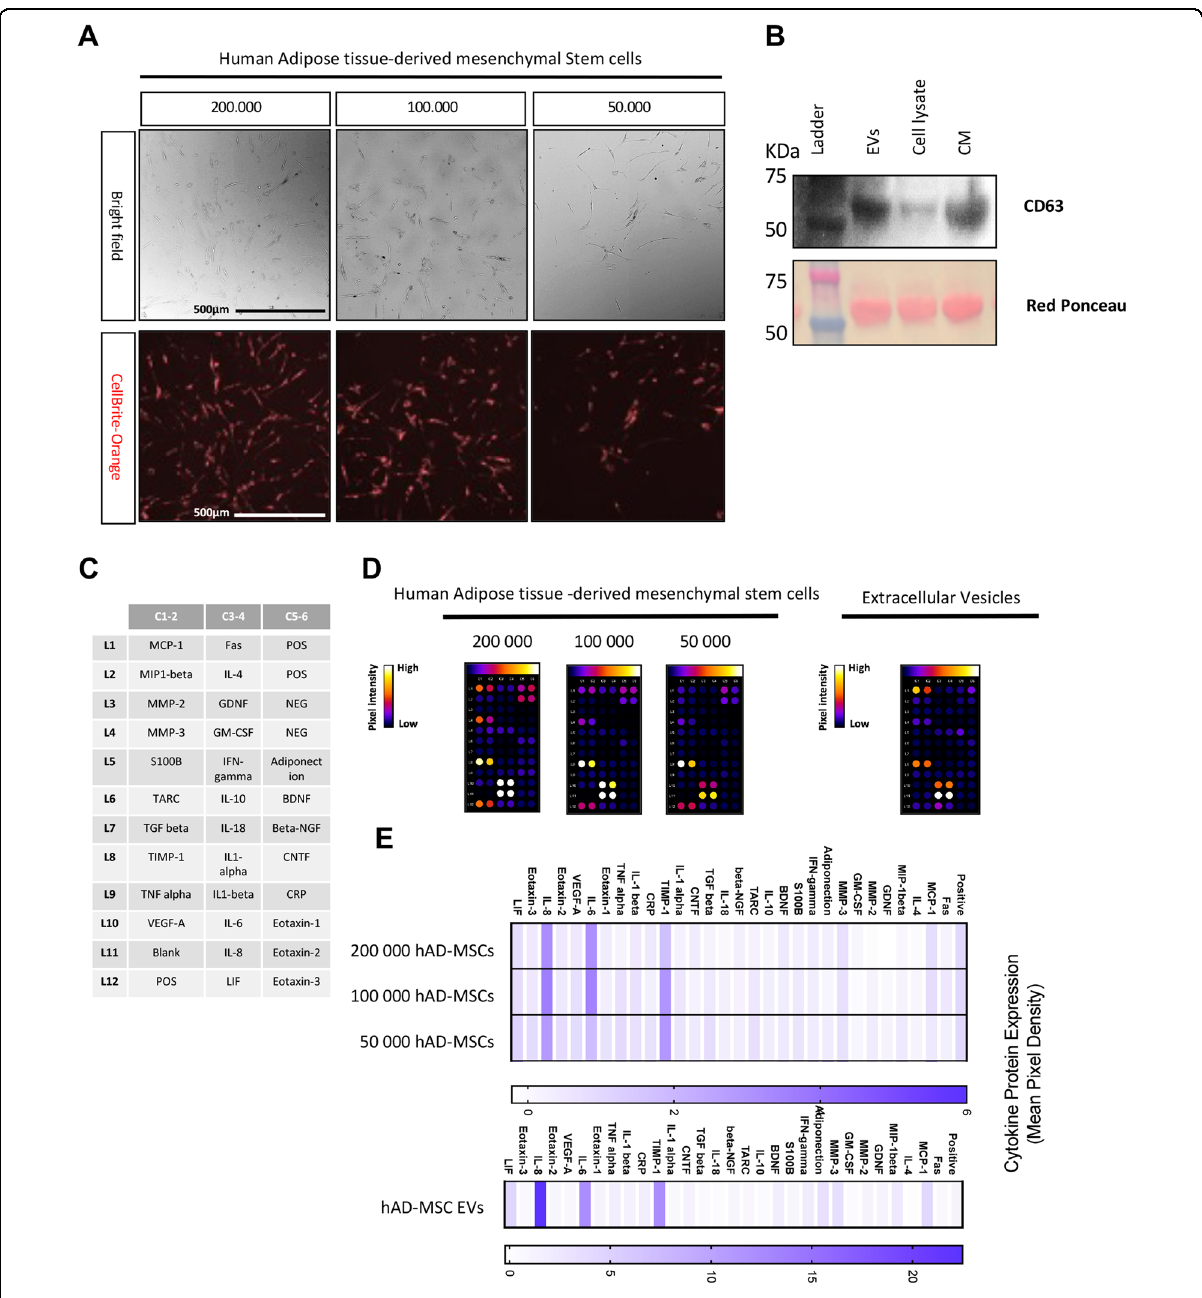
Fig. 2 Human adipose tissue-derived stem cells and extracellular vesicles characterization. A Morphology of isolated hAD-MSCs after 24 h in culture. Representative images are shown. B Western blotting was used to con fi rm the abundances of extracellular vesicle marker CD63 in isolated extracellular vesicles (EVs), cell culture supernatants (CM), and cell lysates. Ponceau red staining is representative of total protein content. C Gene map of cytokine array containing 30 different human neurologically relevant proteins; all spots are in duplicate and D cytokine array membranes. E Heat map showing relative cytokines expression. The values are shown as the mean pixel